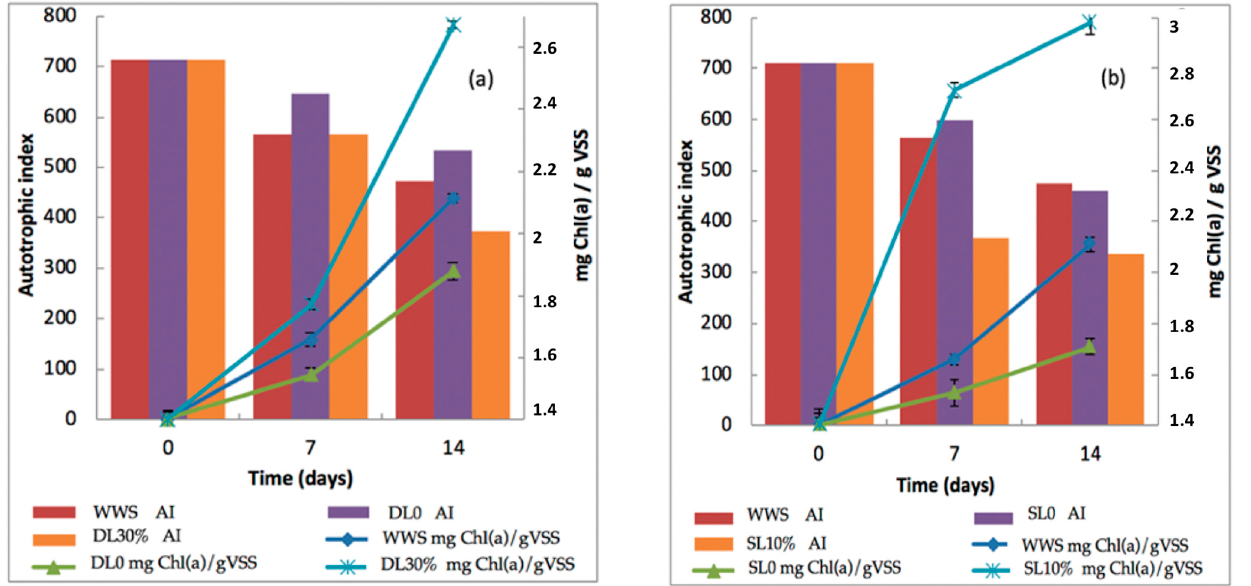
Figure 3. Ma-B flocs biomass productivity evaluated in terms of mg Chl (a) · g − 1 VSS (mean value ± SD) and autotrophic indices after 7 and 14 days of batch culture for different substrates: ( a ) DL, liquid digestate; ( b ) SL, liquid slurry (with and without dilution) and synthetic wastewater (WWS) a a control.